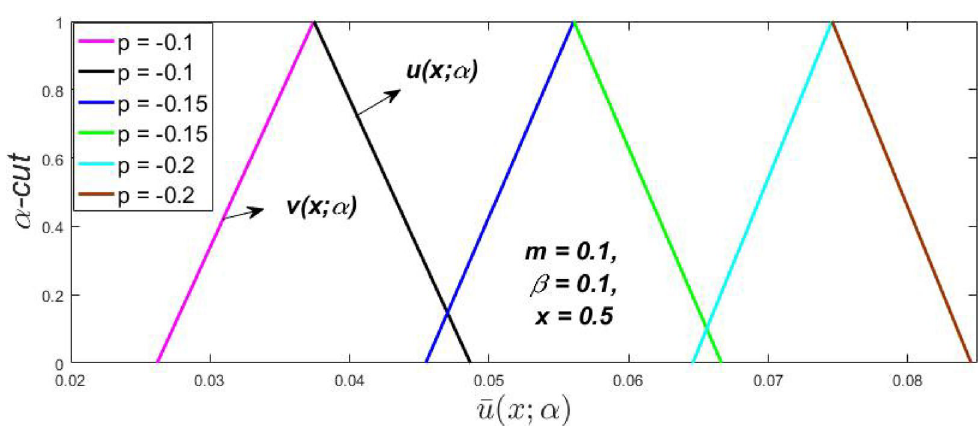
Figure 27. Triangular MF of fuzzy velocity for the impact of p =